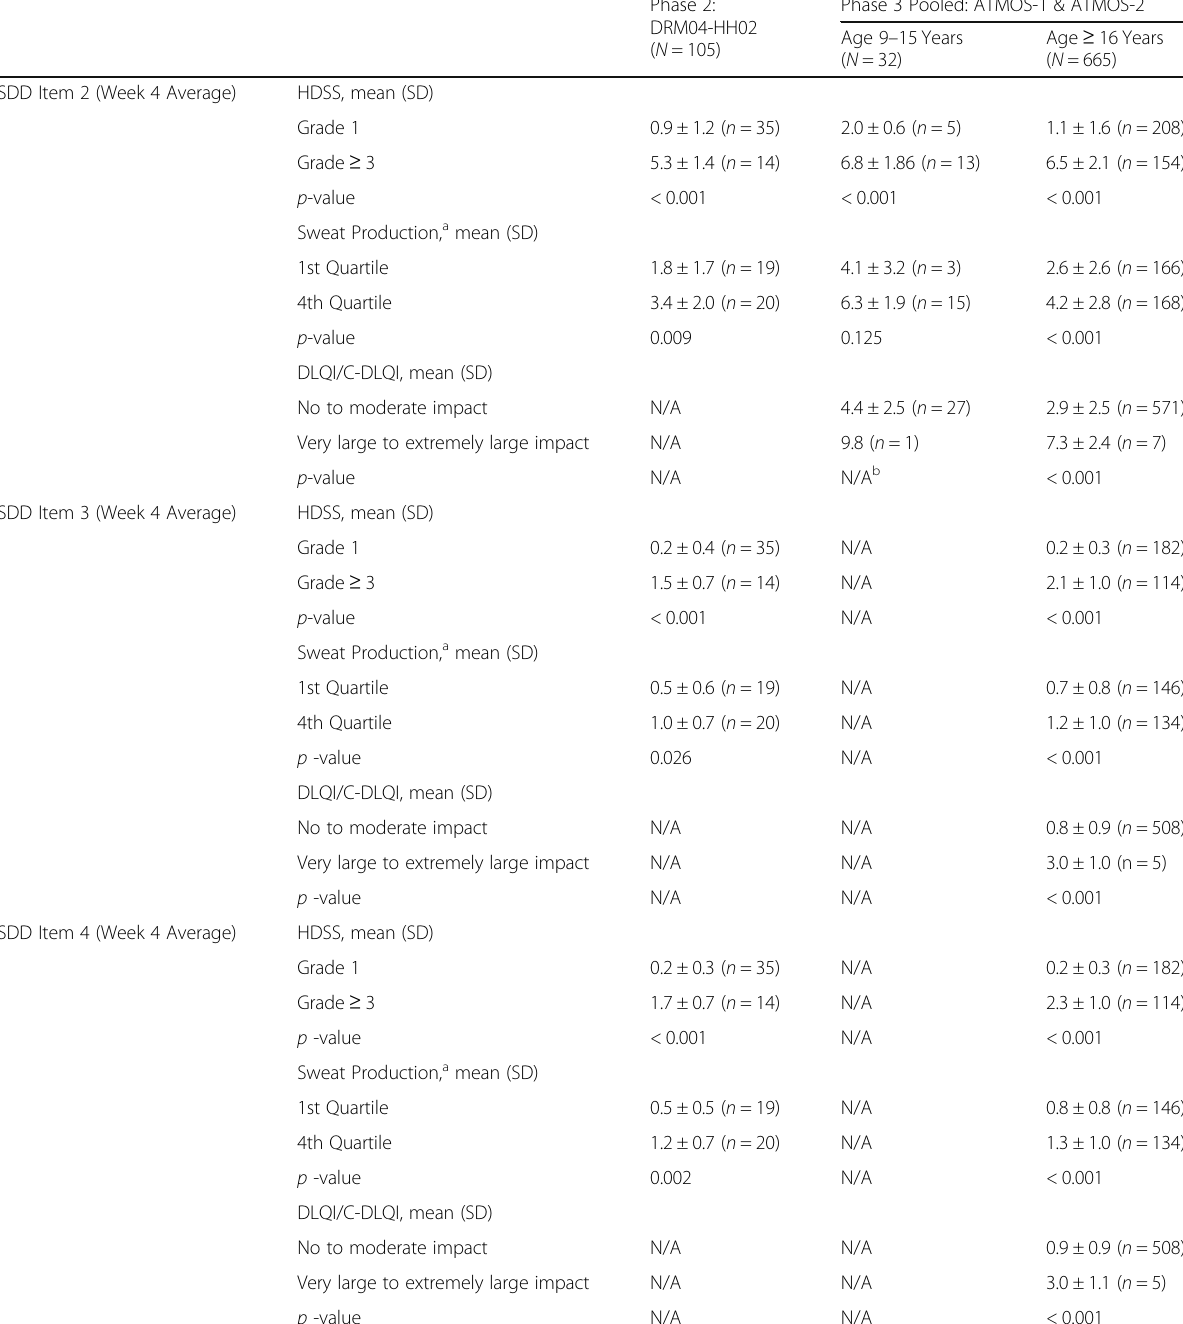
Table 6 Known-Groups Validity – ASDD by HDSS, Gravimetry, and DLQI/CDLQI severity thresholds at Week